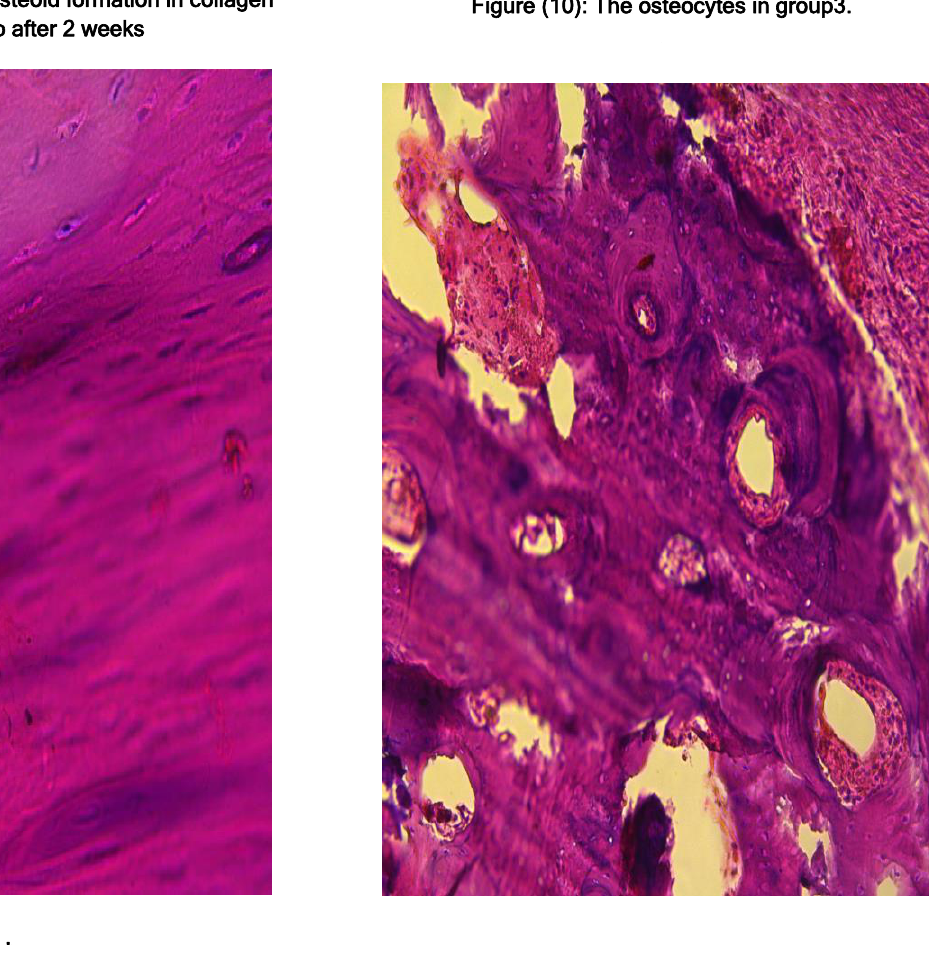
Figure (9): The osteoid formation in biphasic calcium phosphate bone graft (Osteon II) group 3 after 2 weeks.